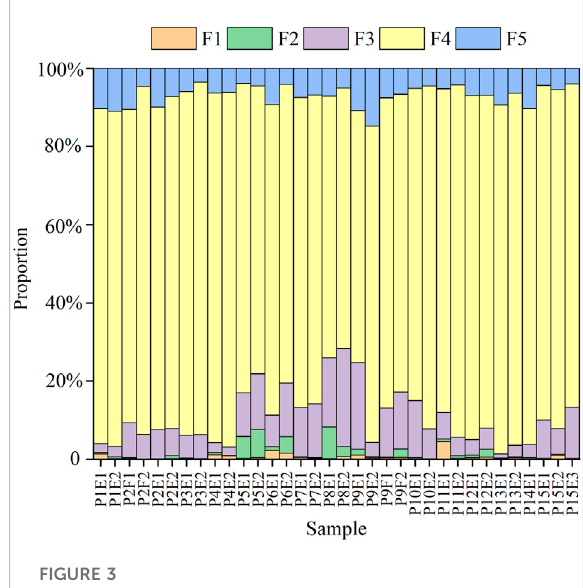
FIGURE 3 Proportion of different Hg forms in the fl y ash samples from CFPPs in Guizhou